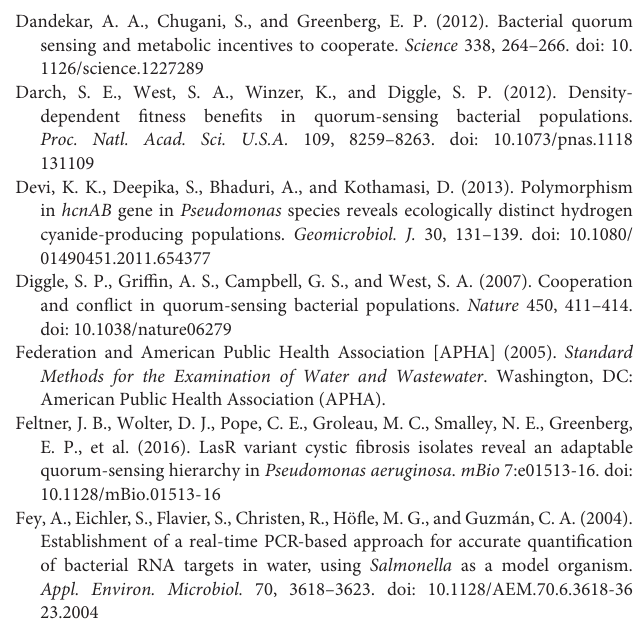
( Figure 4C ), enhances policing in cooperating populations of P. aeruginosa